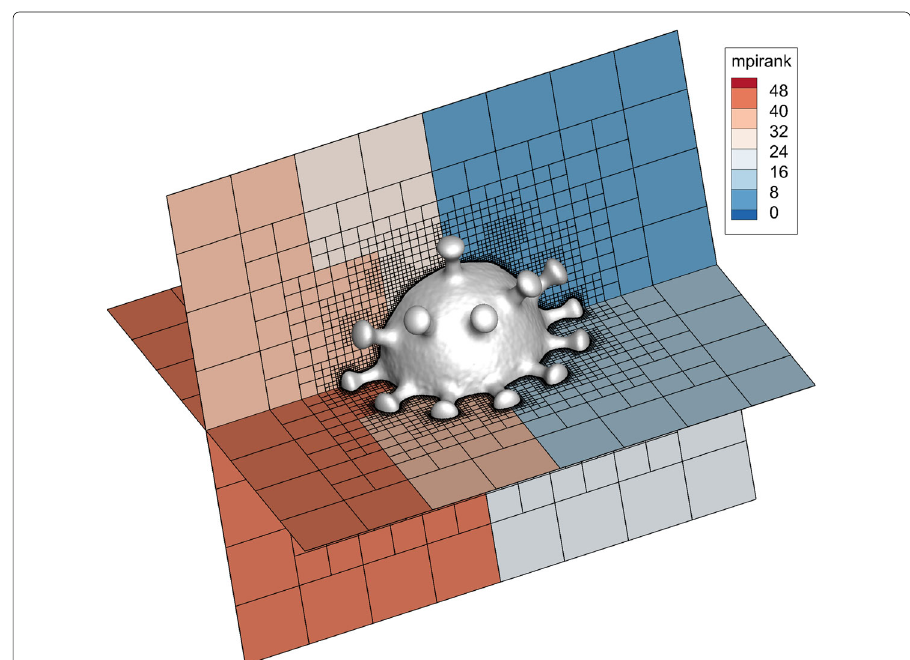
Fig. 4 The adaptive grid generated by CABA for COVID-19